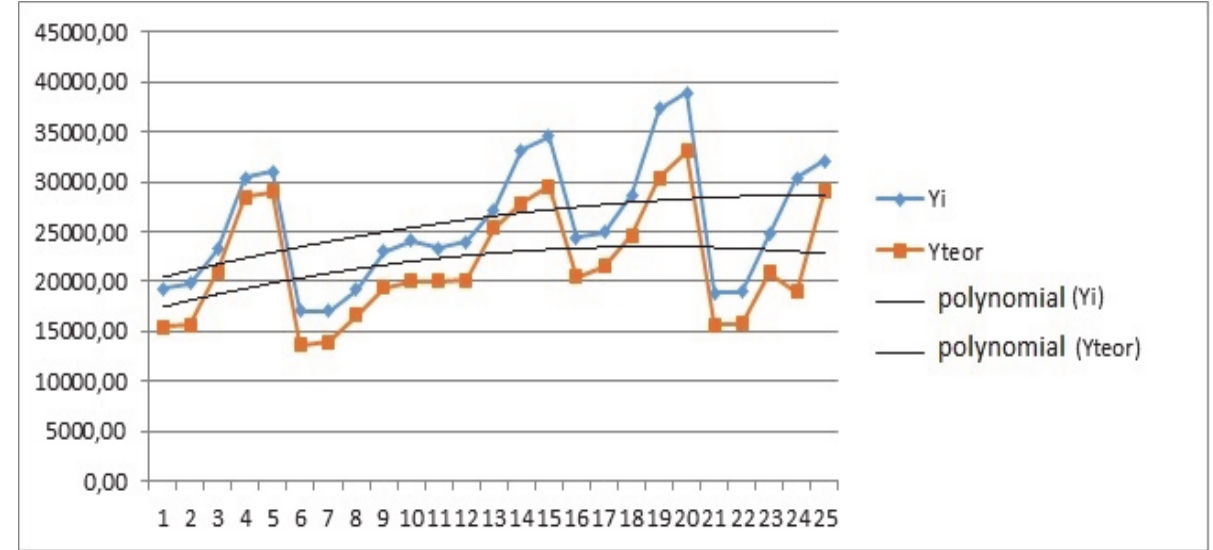
Fig. 1. Graphical comparison of calculated values with statistical data in Excel and their polynomial forecast, where Yi – gross regional product is calculated by model; Yteor – actual gross regional